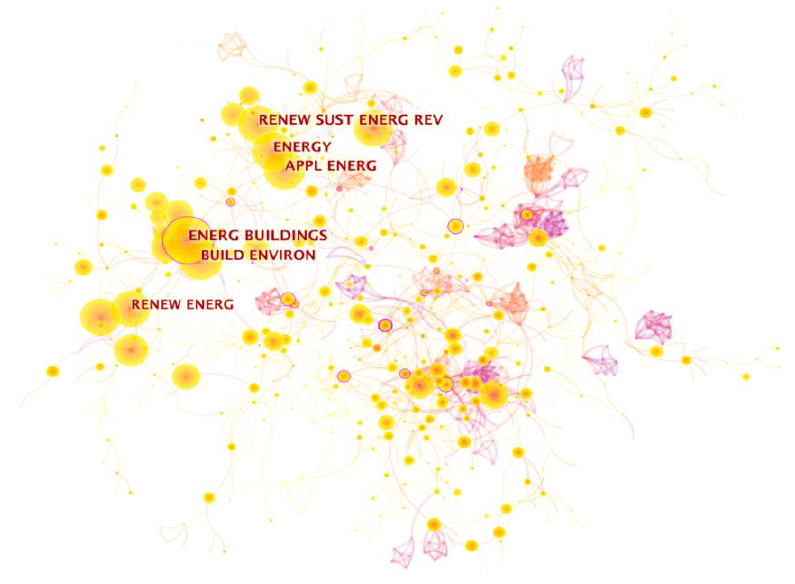
Figure 6. Co-citation clustering of co-cited journals of zero-energy buildings.